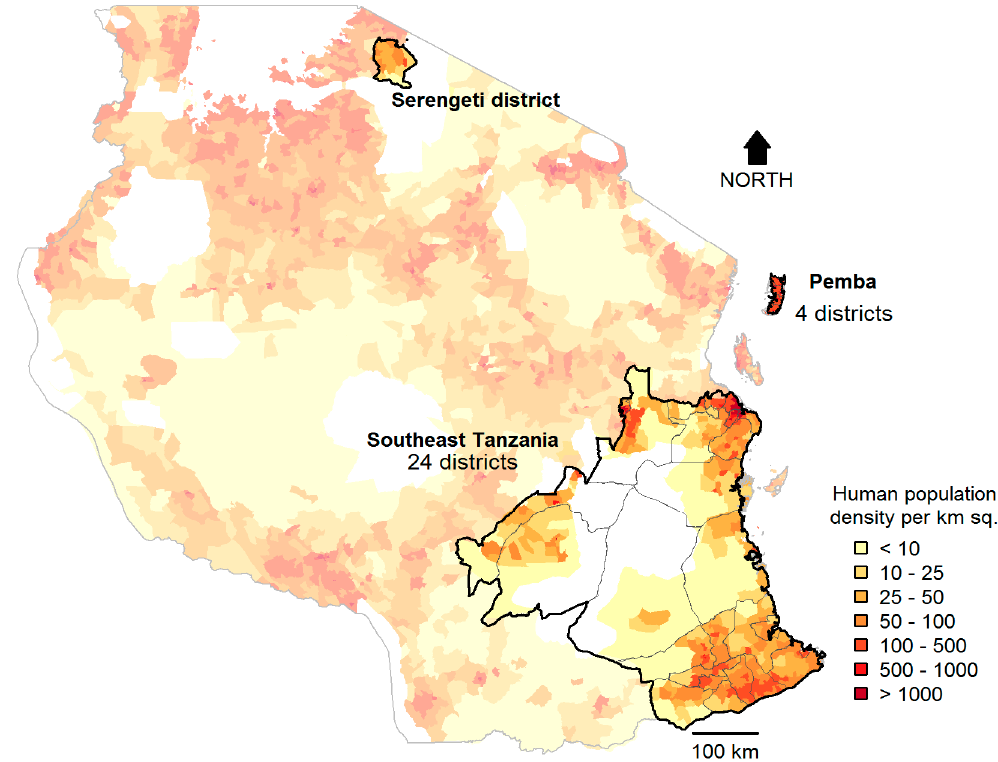
Figure 1. Districts in Tanzania where post-vaccination transects, household, and school-based surveys were conducted. Data were collected in Southeast Tanzania and Pemba (28 districts) where mass dog vaccination campaigns have been conducted since 2011. In Serengeti district, mass dog vaccination campaigns and transects were also conducted in the last quarter of 2015, to assess the performance of the model at predicting dog numbers outside the study area. White coloured areas represent uninhabited protected areas.